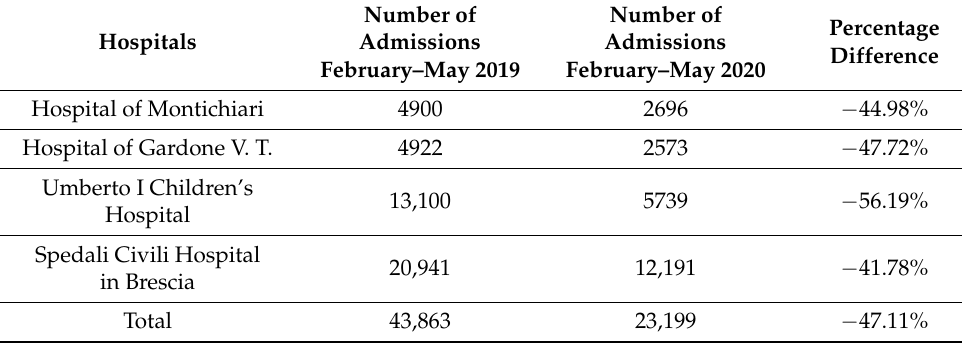
Table 10. Admission to the ER for outpatient